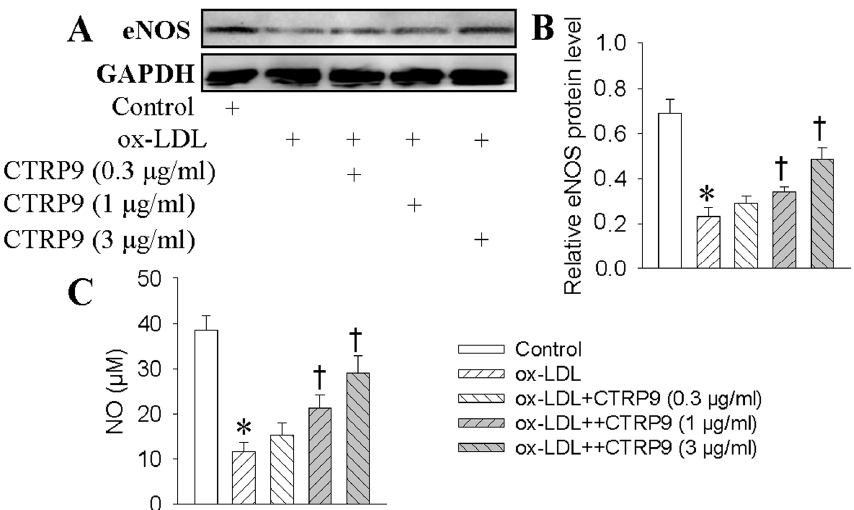
Figure 3. Effects of CTRP9 on the Endothelial Nitric Oxide Synthase (eNOS) expressions and Nitric Oxide (NO) levels in HUVECs stimulated by ox-LDL. HUVECs were pretreated with different doses of CTRP9 (0.3, 1 and 3 µ g/mL) for 6 h, and then were exposed to ox-LDL (100 µ g/mL) for 24 h. ( A ) Representative images of eNOS protein levels; ( B ) Expression levels are represented as density of eNOS relative to that of glyceraldehyde phosphate dehydrogenase (GAPDH). The level of GAPDH was used as a loading control. Image J software was used to quantify the density of the bands. ( C ) NO levels were quantified by Griess assay. Values are mean ± SE. * p < 0.05 vs. Control, † p < 0.05 vs. ox-LDL. n = 4 for each group.